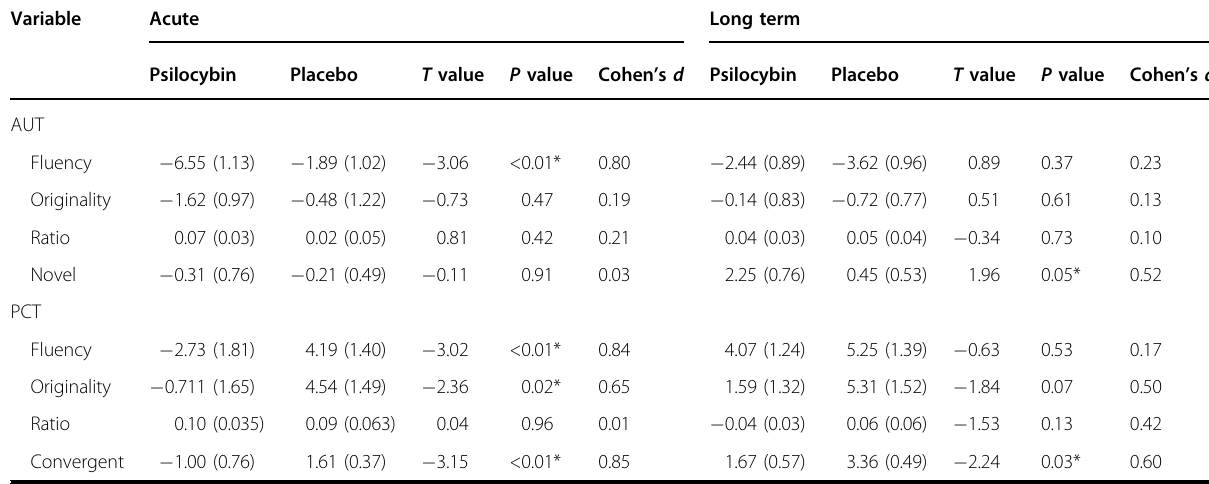
Table 1 Mean (SE) and independent t test results (psilocybin vs placebo) of all dependent outcome variables on the AUT and